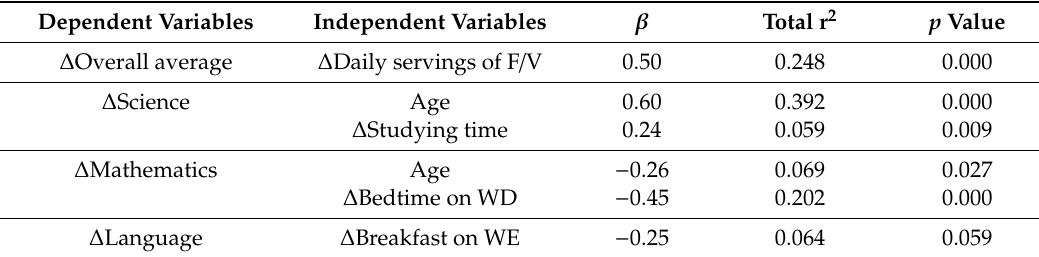
Table 6. Hierarchical regression analysis regarding independent predictors of academic performance in high school male